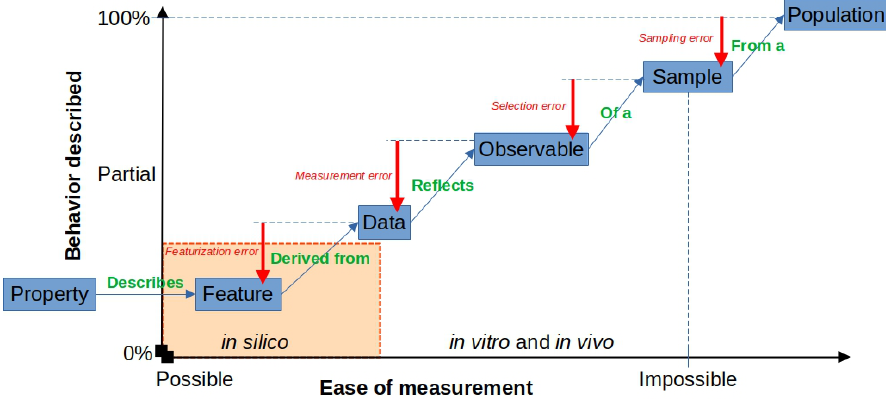
Figure 3. Conceptual relation of six types of representations involved in feature measurement by the amount of physical phenomena they describe, their ease of measurement, and the error incurred by their measurement. Features (boxed in orange) are computational constructs derived from data which describe experimental observables on physical samples retrieved from some population. Each step incurs a new form of error which removes the ability for downstream objects to represent phenomena. It is impossible to measure any sample itself: instead observables of samples are measured. Properties are meta-features that describe features. None of the objects in this diagram are singular: multiple properties can describe multiple features, which are derived from multiple forms of data reflecting multiple observables of multiple samples in several populations. Features are represented in silico, while all other representations exist in vitro or in